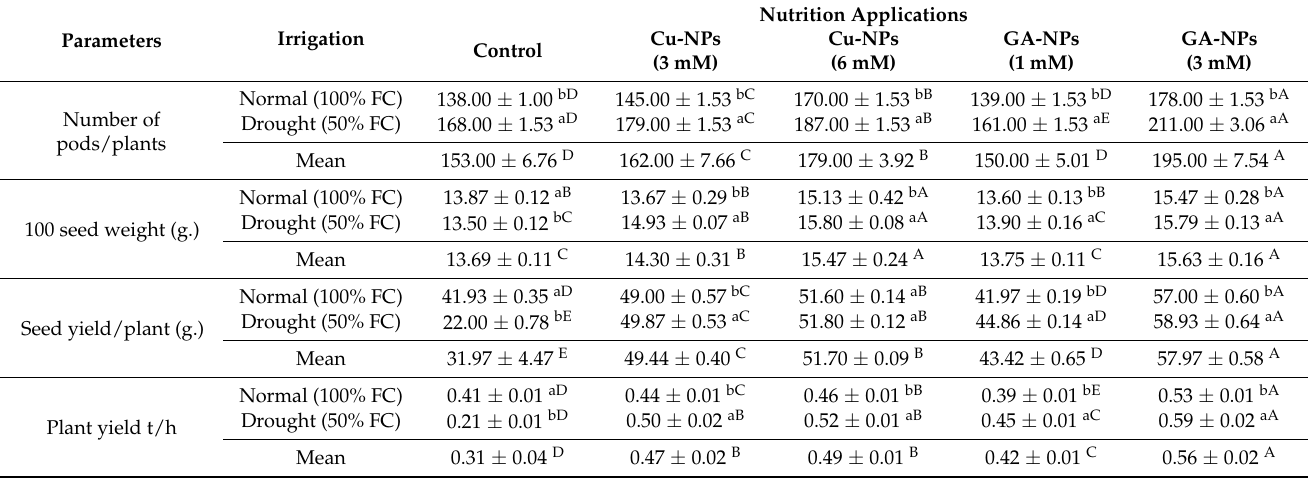
Table 5. Effect of irrigation treatments, Cu-NPs, and GA-NPs applications, and its interaction on the yield of